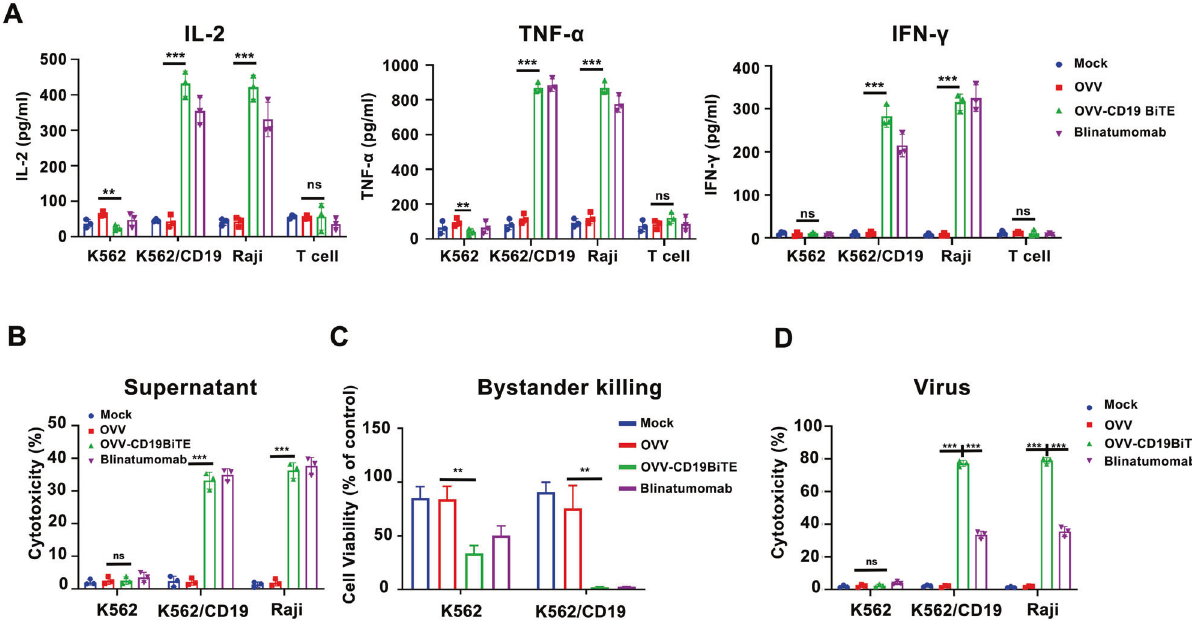
Fig. 3 OVV-CD19BiTE-mediated oncolysis enhances T-cell function and induces a T-cell-mediated bystander effect. A Human T cells were co-cultured with or without K562, K562/CD19, or Raji cells, respectively, in the presence of the OVV supernatants (100 μ l) or blinatumomab (100 ng/ml) for 24 h. Then, average concentration values of IFN- ɣ , TNF- α , and IL-2 cytokines in the supernatants obtained from this co-culture system were measured by ELISA assay. B Preactivated T cells were co-cultured with the indicated target cell lines (E:T = 5) in the presence of the OVV supernatants (100 μ l) or blinatumomab (100 ng/ml). The percentage of cytotoxicity of target cells (CFSE + /7AAD + ) was assessed by fl ow cytometry after 48 h co-culture. C CD19BiTE-mediated bystander tumor cell killing. CFSE-stained K562 cells or K562/CD19 were culture in the presence of T cells (E:T = 5), then the indicated supernatants (mock, OVV, OVV-CD19BiTE) and blinatumomab were added to this co- culture system. After 48 h, cytotoxicity of K562 cells and K562/CD19 cells were evaluated by fl ow cytometry. D Preactivated T cells were co- cultured with the indicated target cell lines (E:T = 5) in the presence of the OVV-CD19BiTE or OVV (MOI = 10) or blinatumomab (100 ng/ml). The percentage of cytotoxicity of target cells (CFSE + /7AAD + ) was assessed by fl ow cytometry after 48 h co-culture. A representative result of triplicates is shown. *** P < 0.001; ns no signi fi cance, using one-way ANOVA test with post-hoc